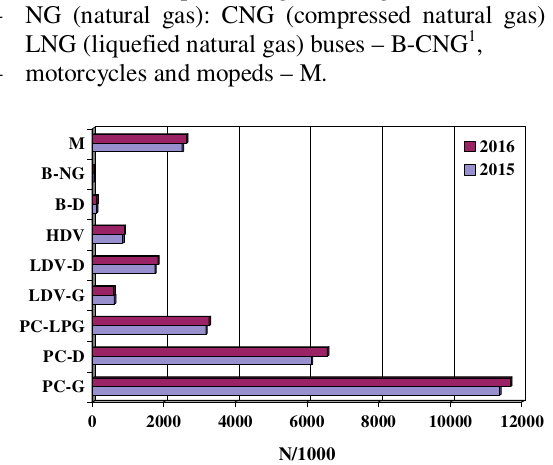
Fig. 1. The number of motor vehicles in Poland in years 2015 and